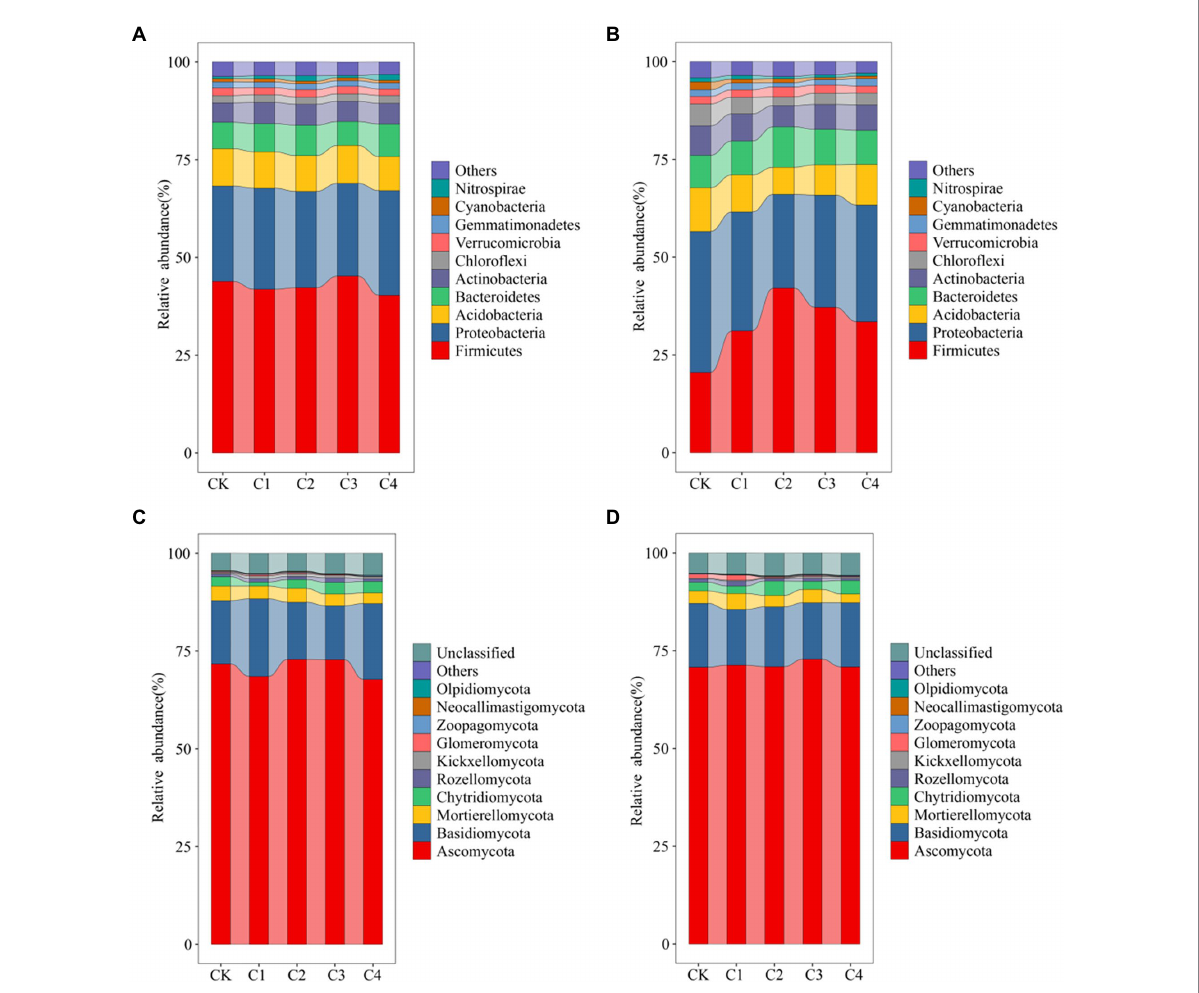
FIGURE 4 Effect of biochar addition on the structure of soil bacterial communities. (A) Bacterial communities in bulk soil at the phylum level (TPO10). (B) Bacterial communities in rhizosphere soil at the phylum level (TPO10). (C) Fungal communities in bulk soil at the phylum level (TPO10). (D) Fungal communities in rhizosphere soil at the phylum level